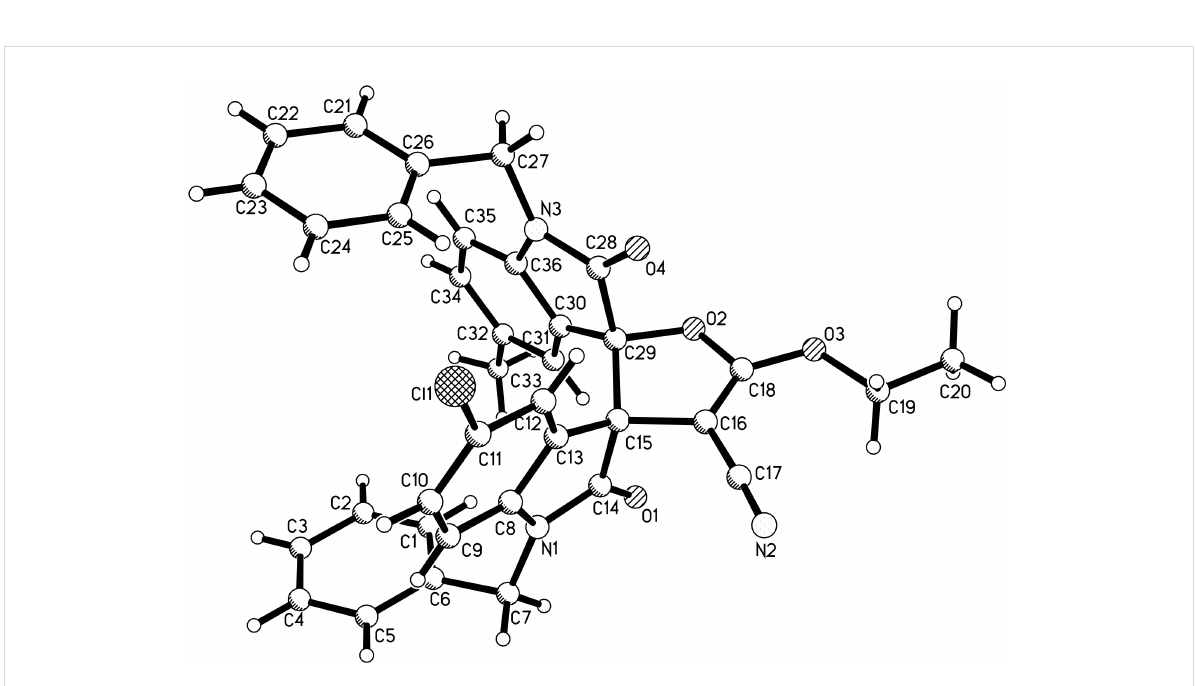
Figure 5: Single crystal struture of compound 8a